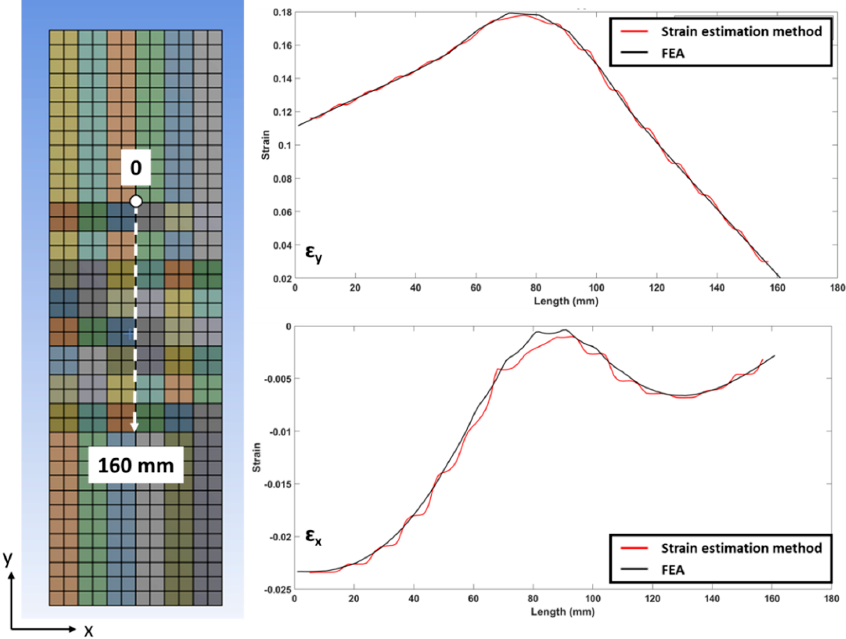
Figure 8. Strain comparison along the centre line of the region of interest.